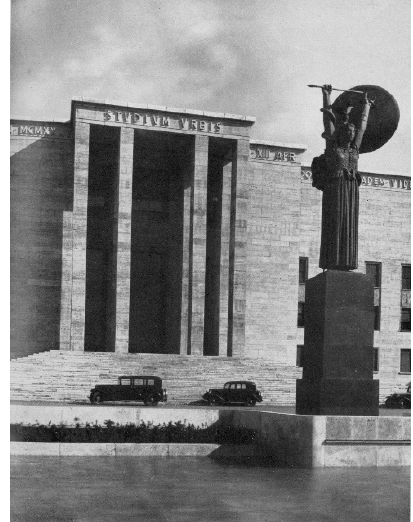
Figure 28. The Rectorate by Marcello Piacentini. Photo from (Baliviera et al. 1935, p. 9). Arts 2019 , 8 , x FOR PEER REVIEW